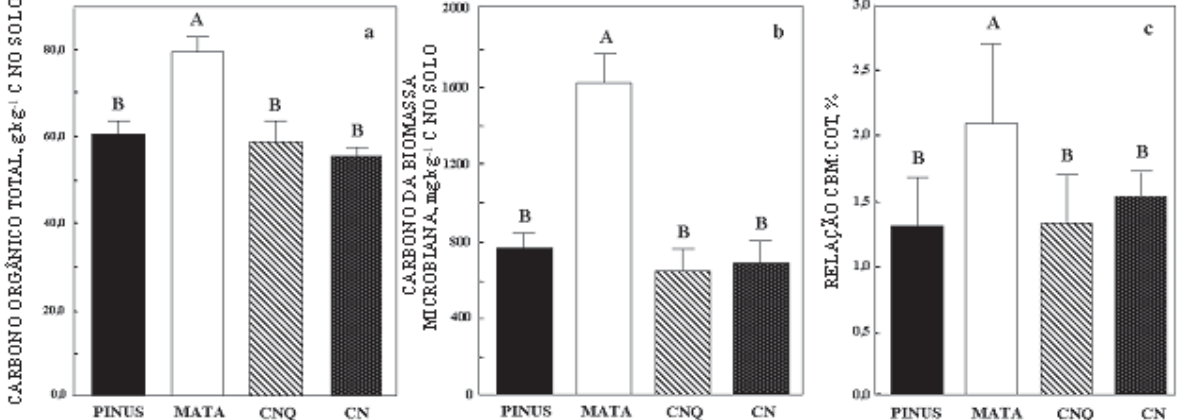
Figura 2. Carbono orgânico total (a), carbono da biomassa microbiana (b) e relação CBM:COT (c), em quatro tratamentos de manejo de solo na região de Lages, SC (2002). Letras diferentes, em cada tratamento, indicam diferença significativa pelo teste de Duncan a 5 %. CN: campo nativo; CNQ: campo nativo submetido à queima; PINUS: monocultivo de Pinus taeda ; MATA: mata natural com predominância de Araucaria angustifolia